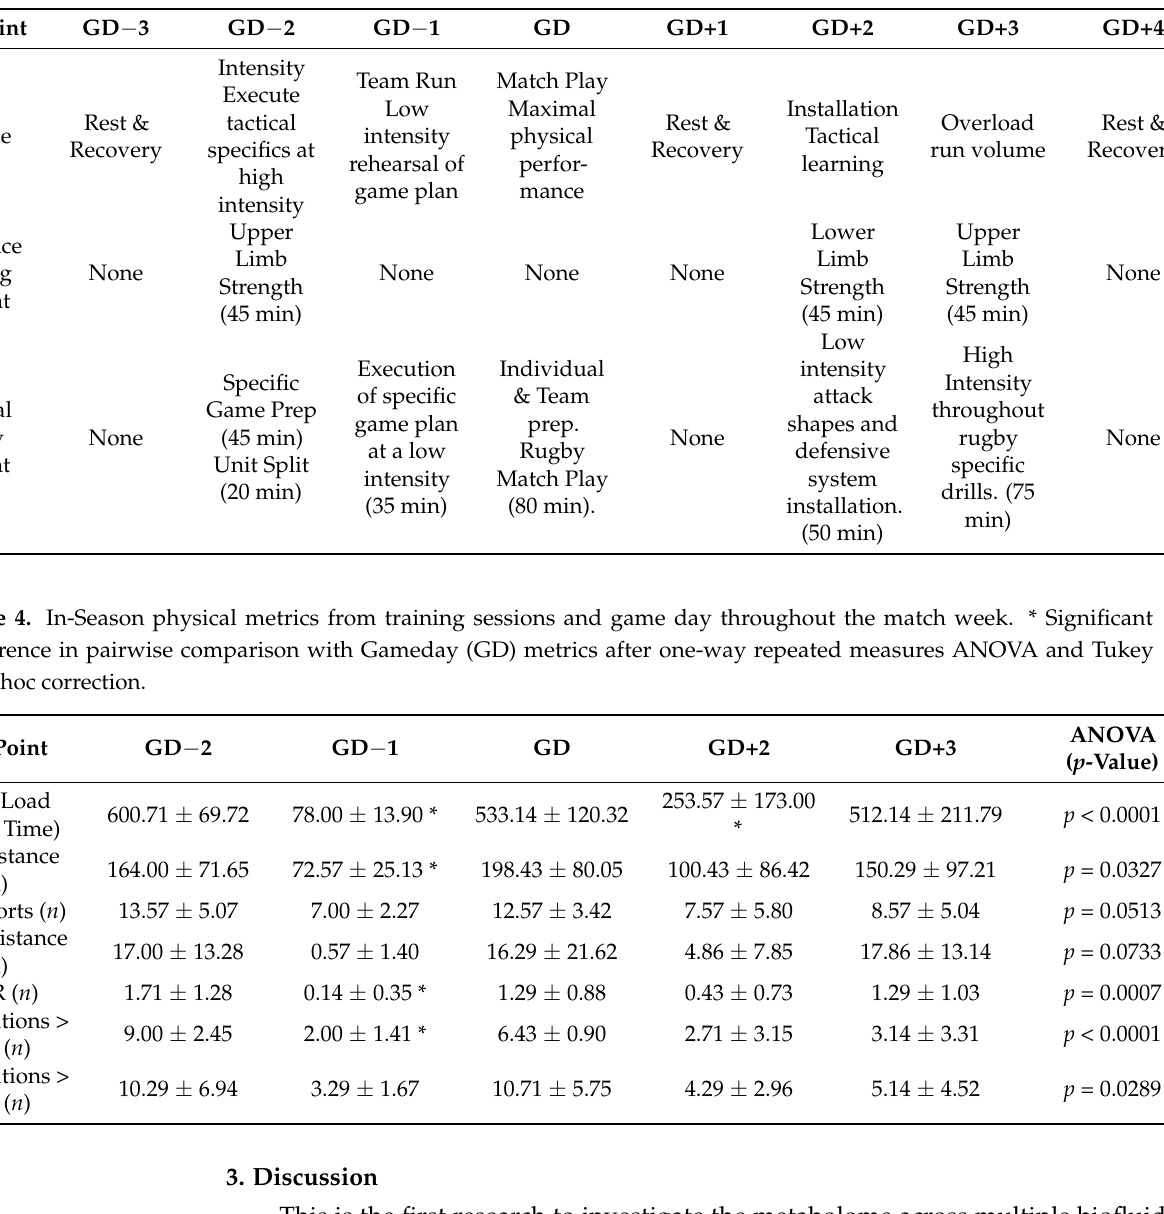
Table 3. The in-season training schedule including session content and physical objectives.